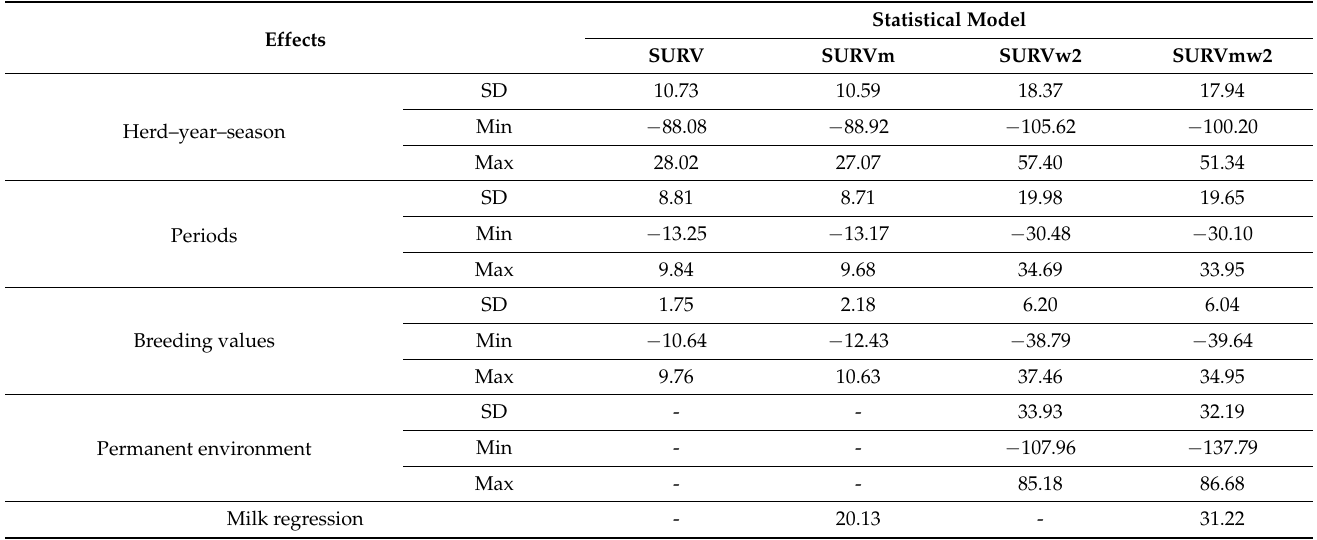
Table 5. Estimates and solutions of fixed and random effects from mixed-model analyses of un- weighted and weighted survival of culling and involuntary culling.